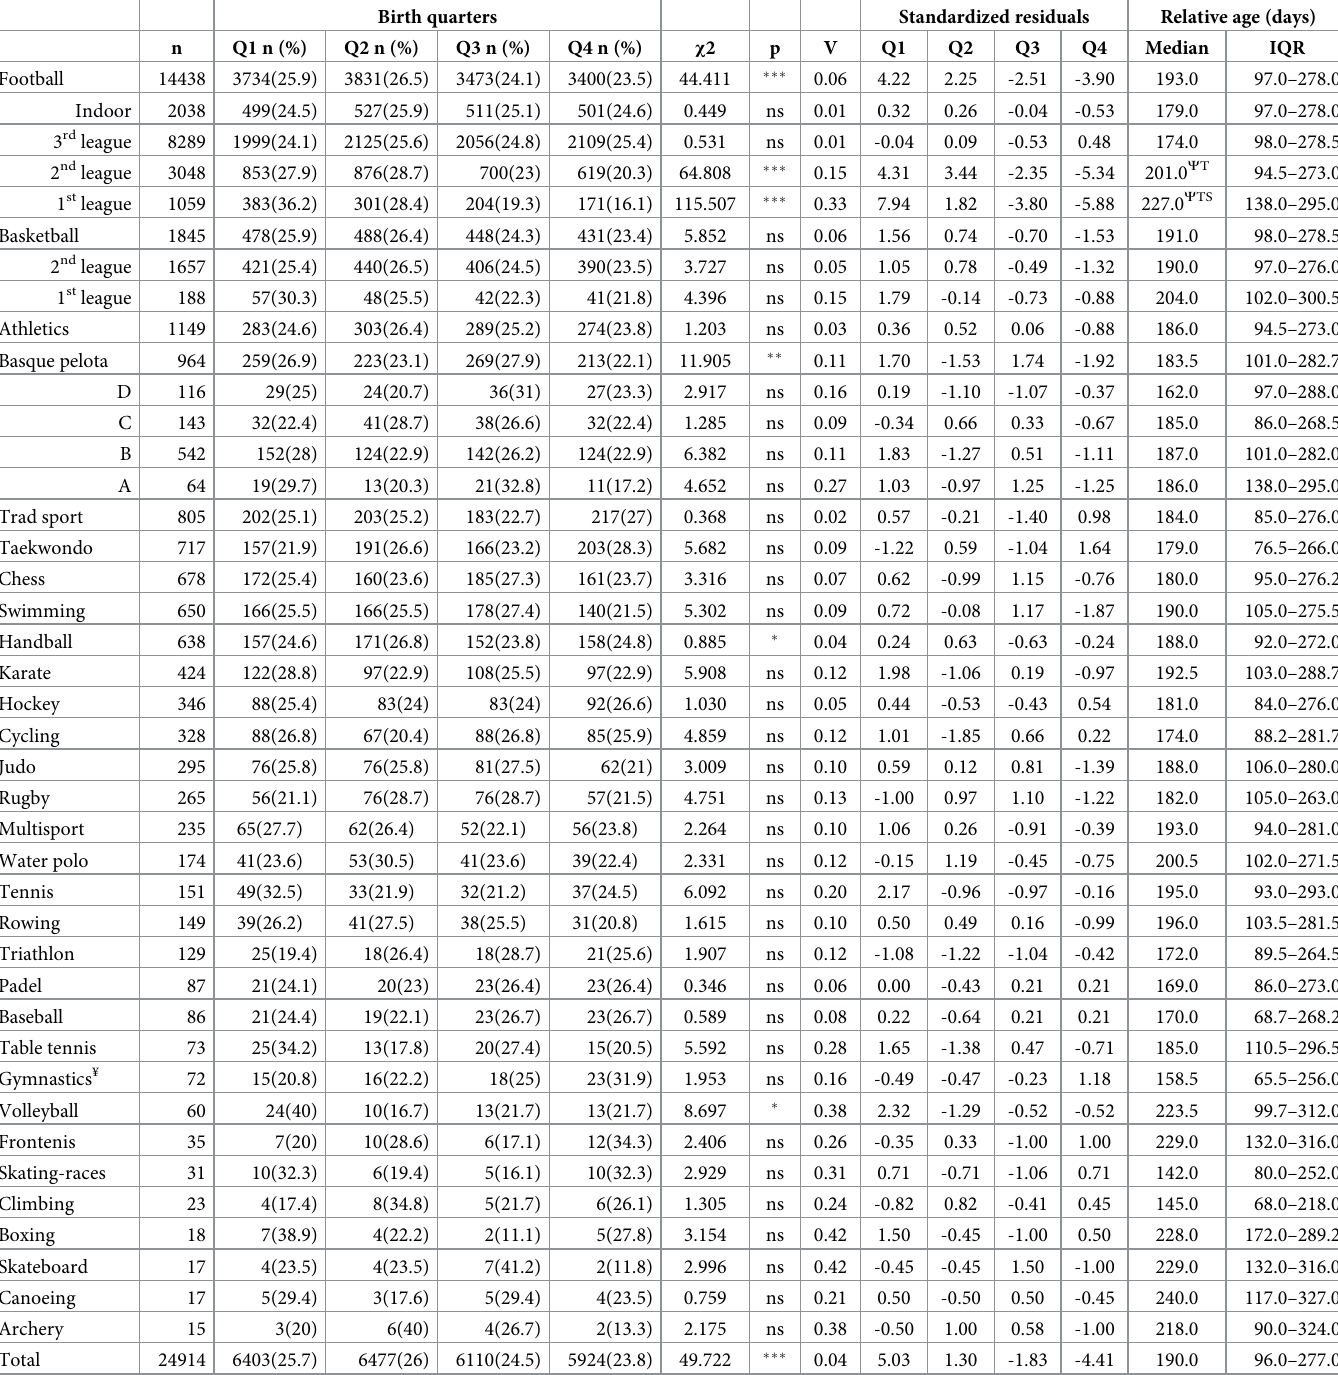
Table 1. Descriptive statistics of the birth distribution of all male sport participants (9–14 years old) and the general